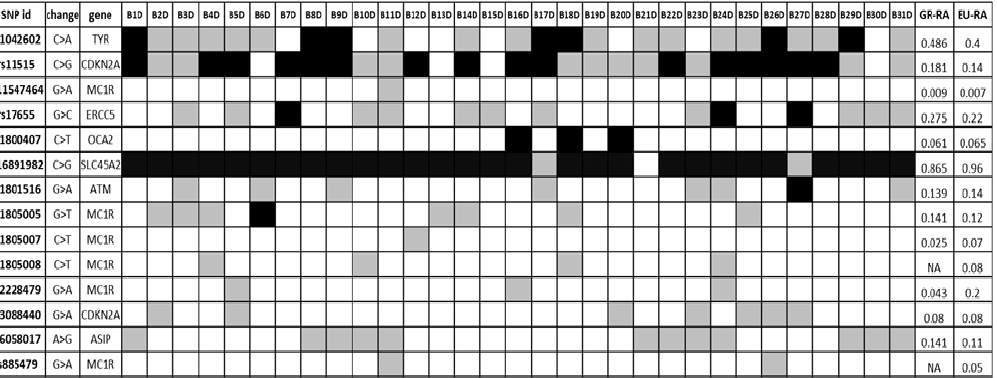
Figure 1. Germ-line SNPs putatively associated with melanoma risk; black = homozygous for melanoma risk-associated allele (RA), white = homozygous for reference allele, grey = heterozygous. GR-RA: Frequency of the risk allele in the Greek population, EU-RA: Frequency of the risk allele in the European population.